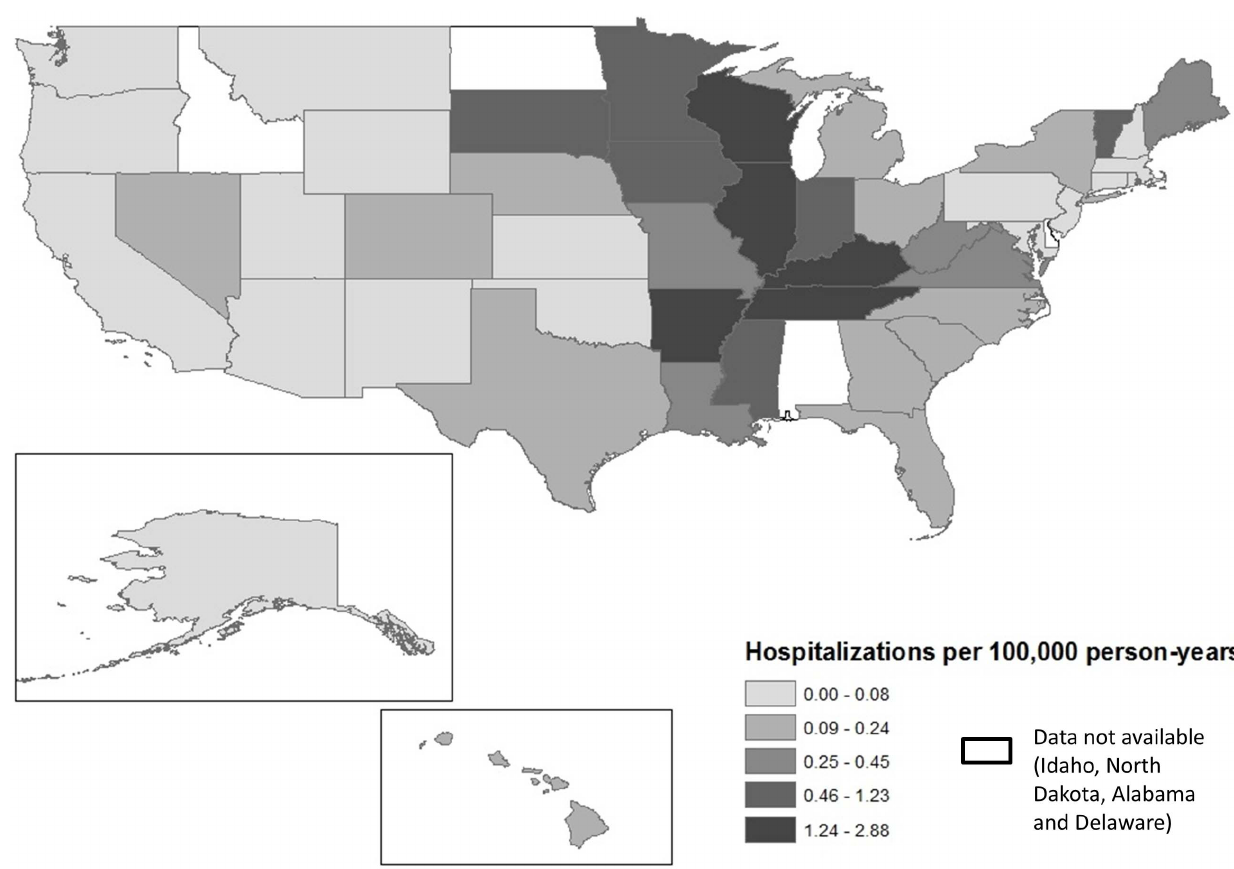
Figure 1. Map of age-adjusted blastomycosis-associated hospitalization incidence in the United States.